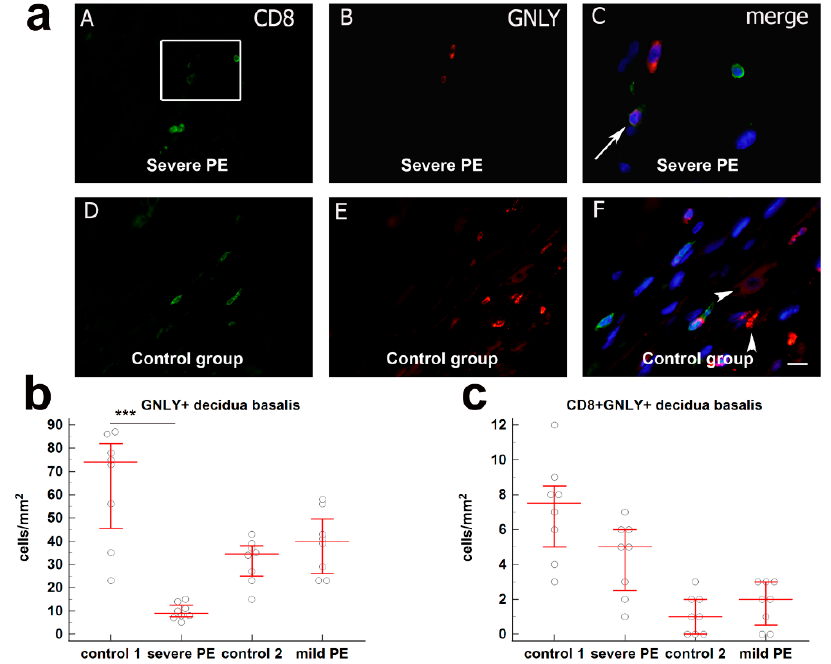
Figure 3. ( a ) ( A – C ) Co ‐ expression of CD8 and GNLY markers in decidua basalis cells of the third